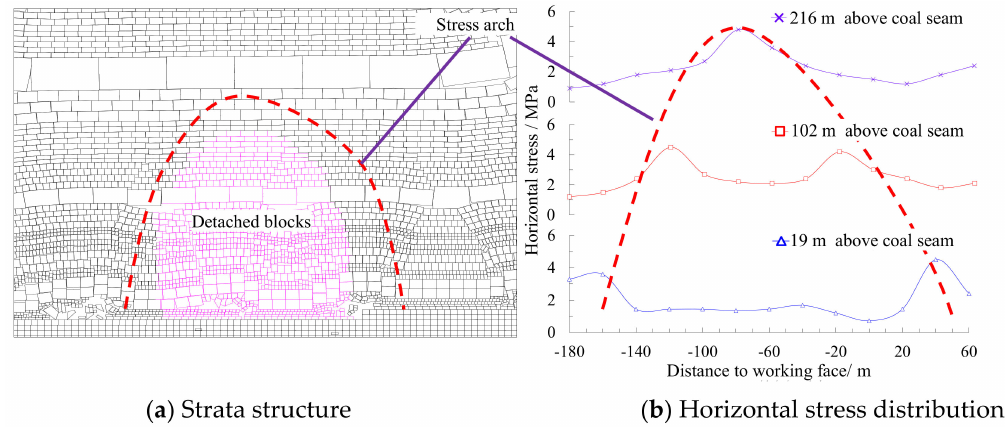
Figure 9. The failure pattern and stress measurements for the overburden after the 5th layer extraction.